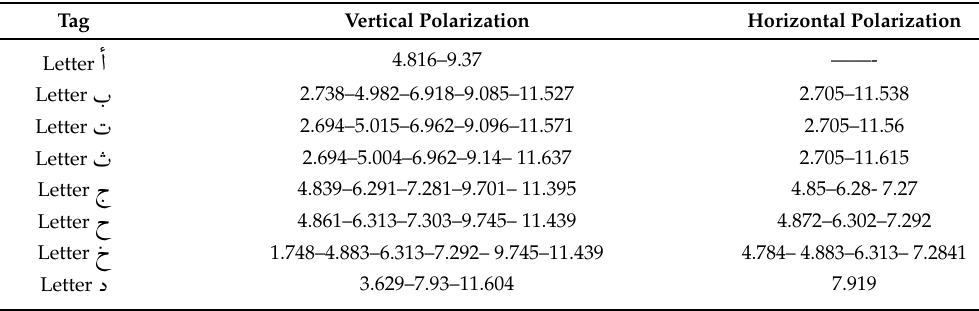
Figure 6. RCS results of Arabic letter tags ( (cid:160) , (cid:9) (cid:160) , ¤ , (cid:168) , and font size of 28. Table 1. Co- and cross-polar resonate frequencies of designed Arabic tag IDs with Arial font type of size 28 (waveforms in Figures 5 and 6).